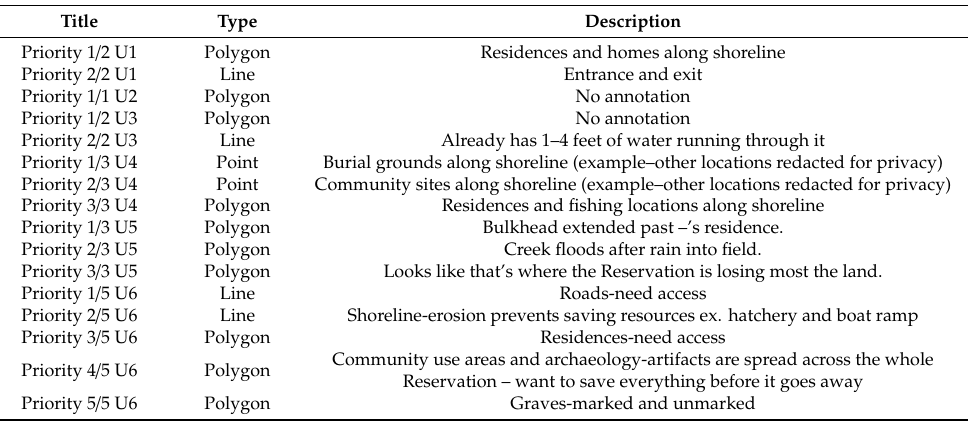
Figure 3. Web app input with 2080 SLR. Table 1. Web app input descriptions.